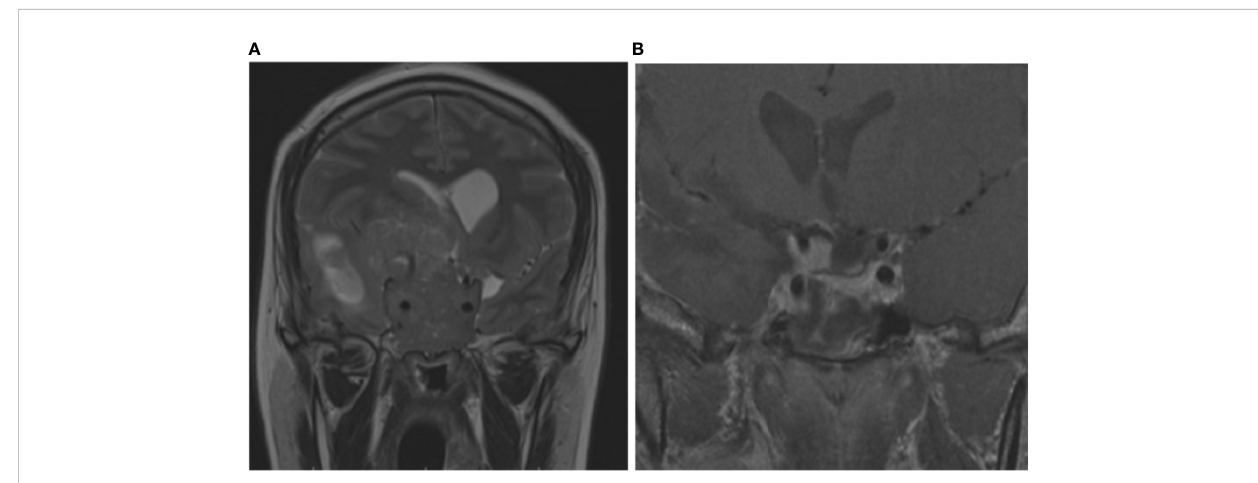
FIGURE 3 Coronal and sagittal MRI of individual III.2 (family 4). Giant pituitary adenoma with suprasellar extension reaching the right frontoparietal region, with invasion of cavernous sinus and third ventricle (A) . Six months after surgery and cabergoline, the tumor exhibited signi fi cant shrinkage and necrosis (B) .